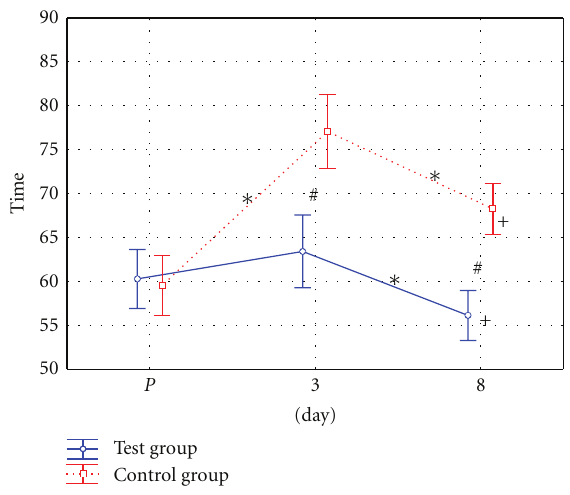
Figure 3: Graphic distribution of 100-metre walk test time (in secs.) in patients from test and control